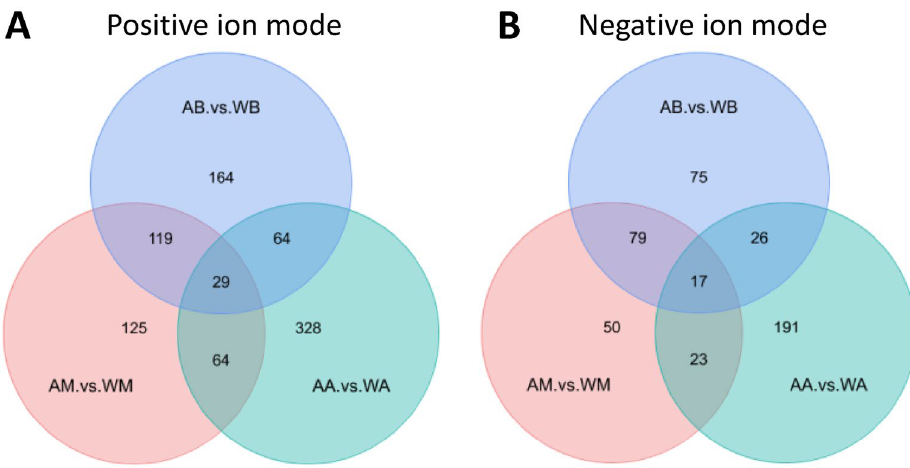
Figure 3. Venn diagram analysis of differential metabolites of cultivated and wild Inonotus hispidus in different growth periods comparative combinations. ( A ) Under the positive ion mode and ( B ) under the negative ion mode. Note: AB, AM, and AA are samples of fruiting bodies of cultivated Inonotus hispidus in budding, mature and aging growth periods, respectively. WB, WM, and WA are samples of fruiting bodies of wild Inonotus hispidus in budding, mature and aging growth periods,